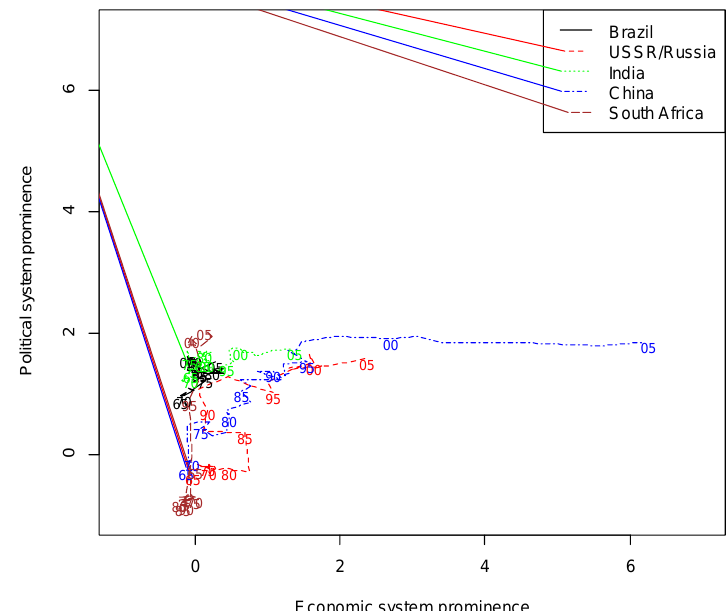
Figure 5. Evolution of Economic and Political System Prominence Scores for BRICS Countries